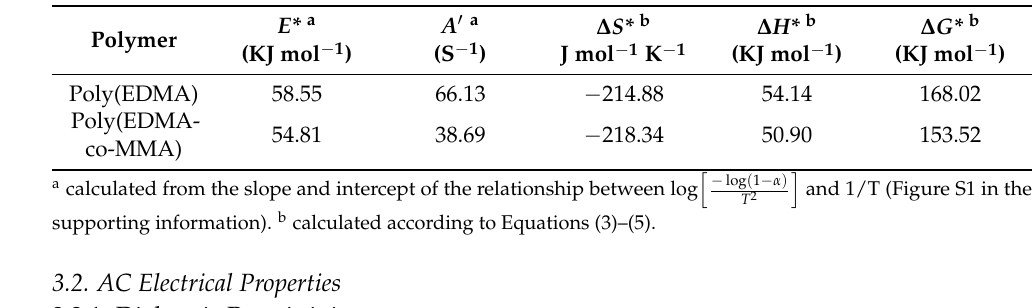
Table 1. Thermal activation energy and thermodynamic parameters of poly(EDMA) and poly(EDMA-